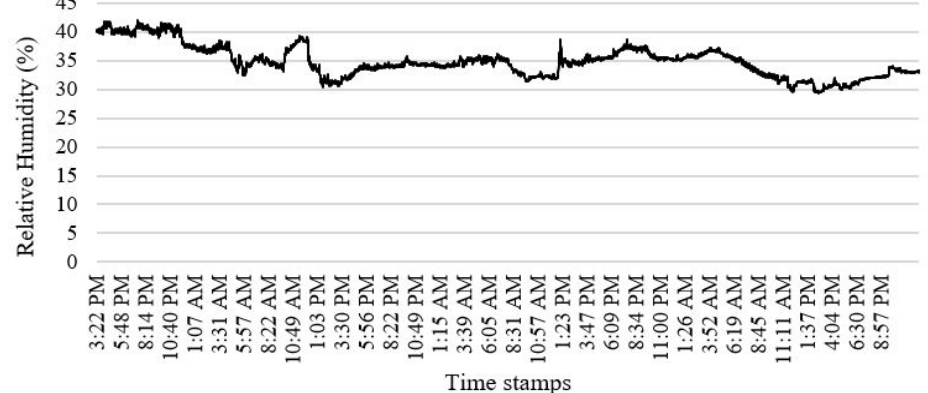
Figure 21. The recorded Relative Humidity data trends.